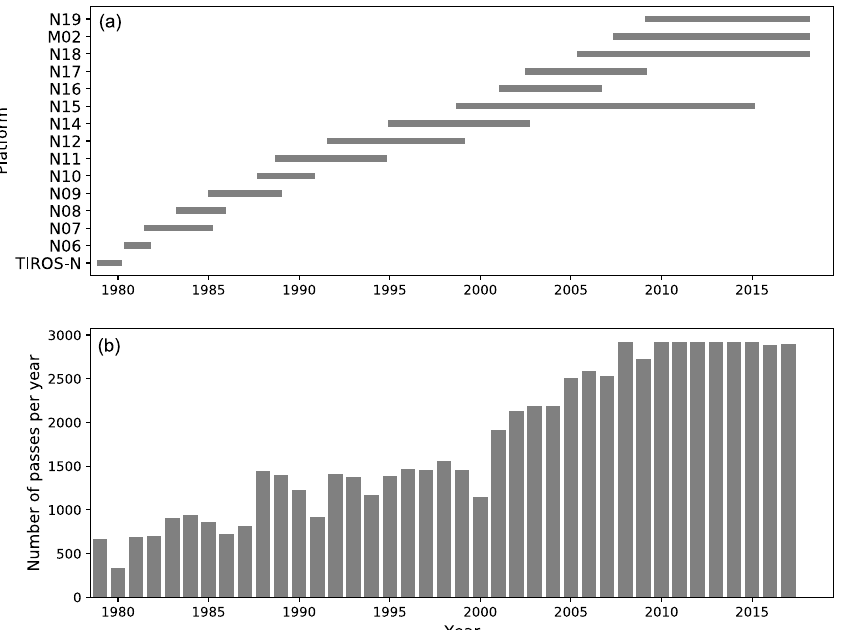
Figure 1. PATMOS-x v5.3 (Px5.3) data density. (a) The length of the individual AVHRR missions: TIROS-N (the NASA-operated Television Infra-Red Observation Satellite); NOAA-operated missions (N); and MetOp (M) missions operated by EUMETSAT. (b) Number of satellite orbits per year which comprise the Px5.3 data